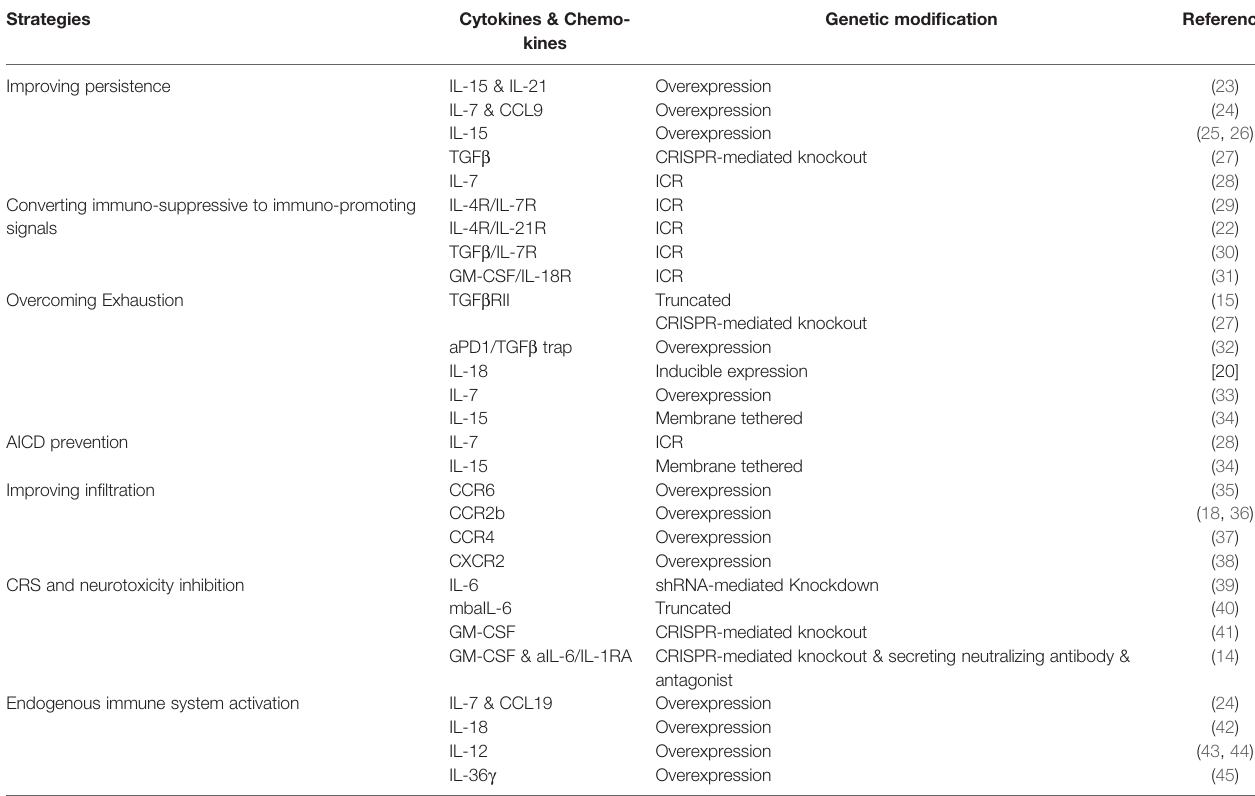
TABLE 1 | Novel genetic modi fi cations in cytokine, chemokine and their receptors to enhance the ef fi cacy of CAR T cell therapy. Strategies Cytokines & Chemo-